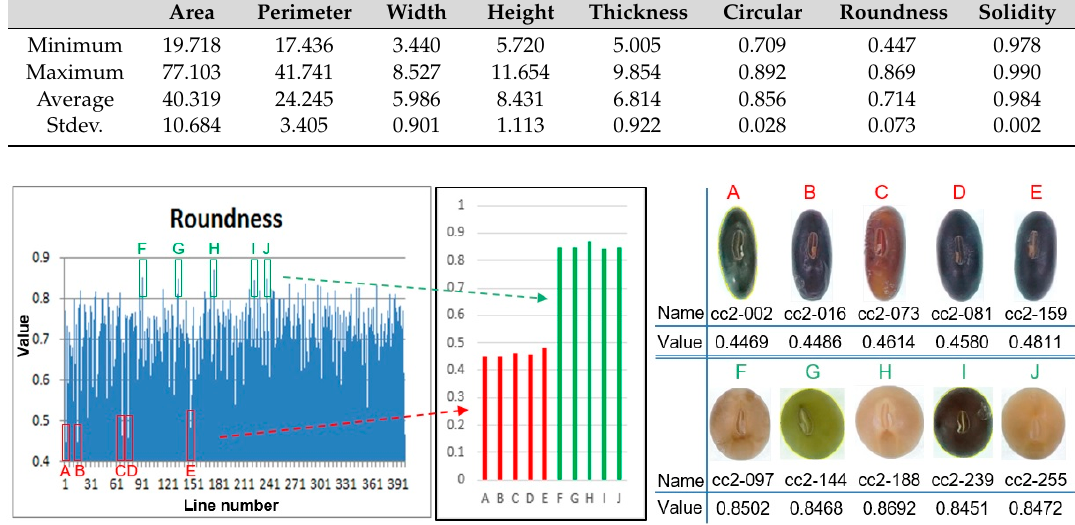
Figure 4. Classification of morphological phenotype data of the Roundness. A red box (A, B, C, D, E) with an elongated shape has a roundness value of 0.4~0.5 and a green box (F, G, H, I, J) with a close to a circle shape has a roundness value of 0.8 or